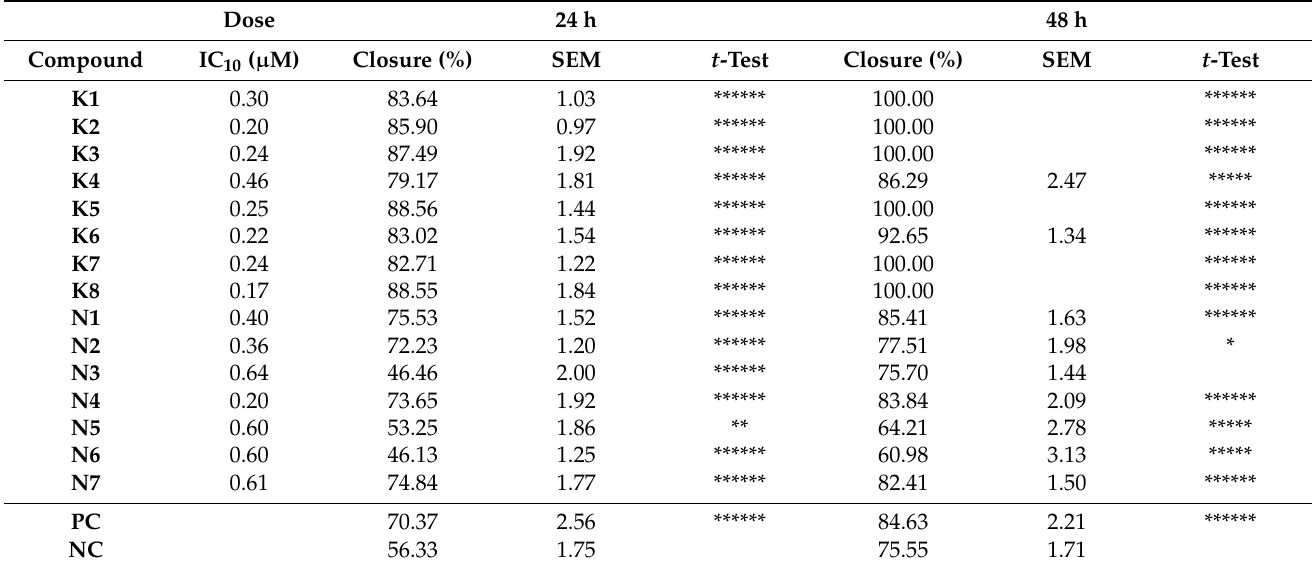
Table 8. Wound healing activity determined as keratinocytes’ (HaCaT) wound closure (%) after 24 and 48 h. Allantoin (50 µ g/mL) served as a positive control. Data represent the average of twenty repetitions (four biological, five technical) with corresponding standard error of the mean. The data were analysed with t -test, where the difference between the group and negative control was considered statistically significant when p < 0.0000005 (******), 0.000005 (*****), 0.00005 (****), 0.0005 (***), 0.005 (**), and 0.05